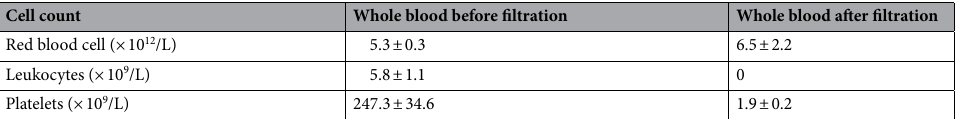
Table 1. Cell counts before and after filtration of whole blood by LEUCOFLEX® LXT filter (mean ± standard deviation, n = 3).